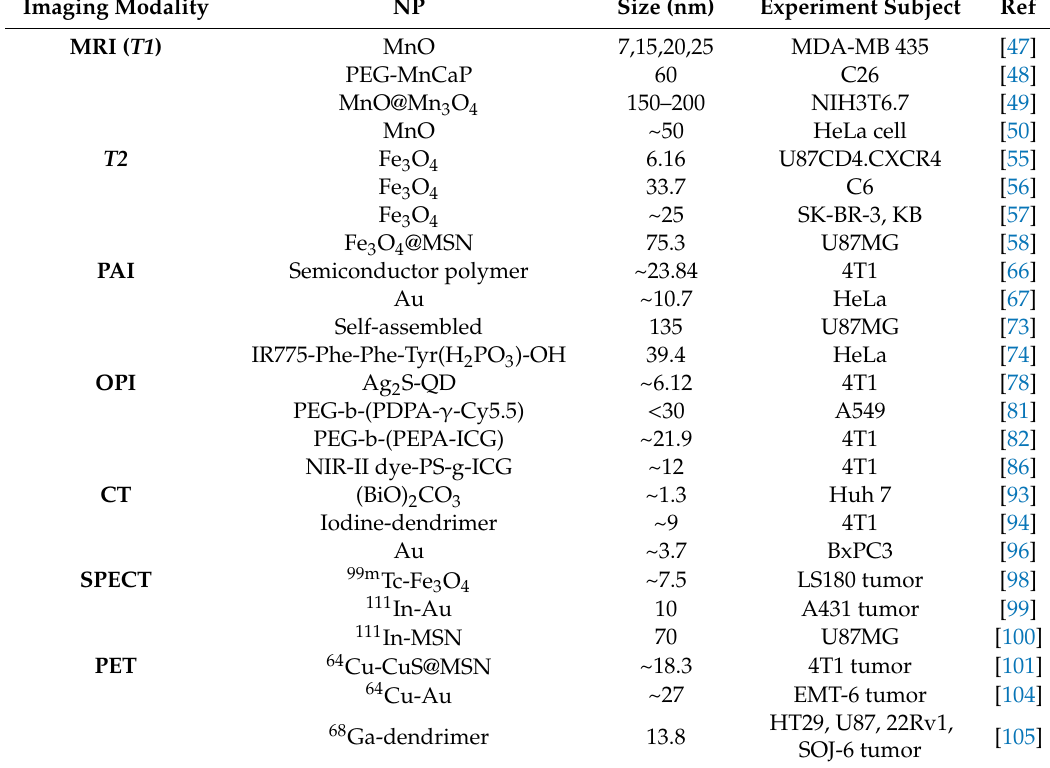
Table 2. NP-based contrast agents for imaging